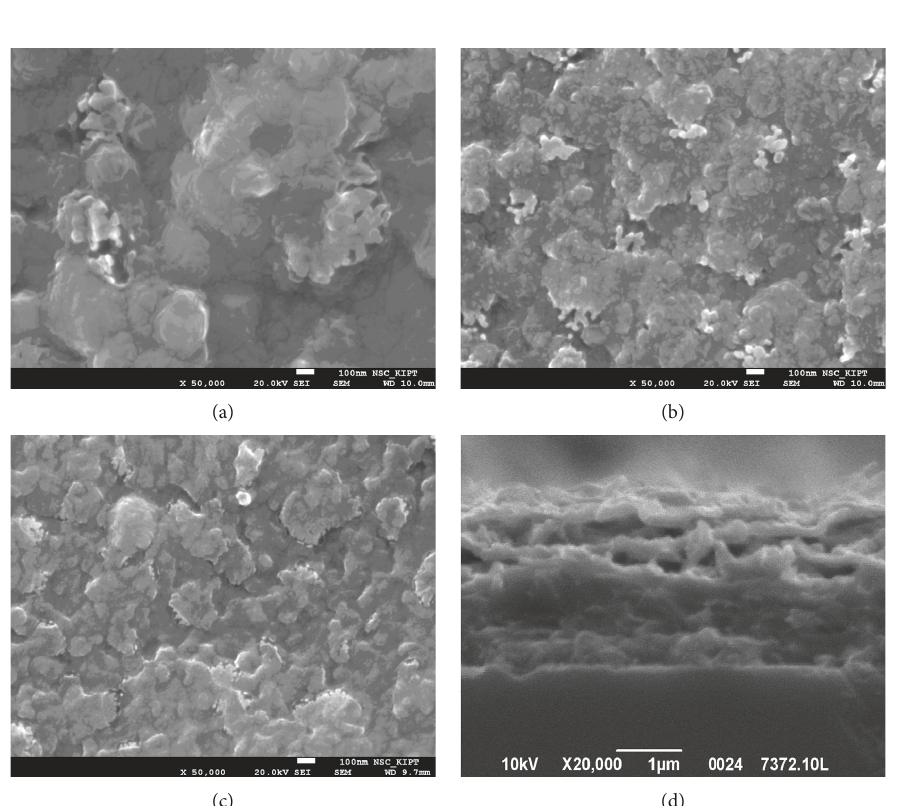
Figure 4: SEM images of the surfaces of nc-SiC films of A (a), B (b), and C (c) types and the cross section of nc-SiC film of C-type